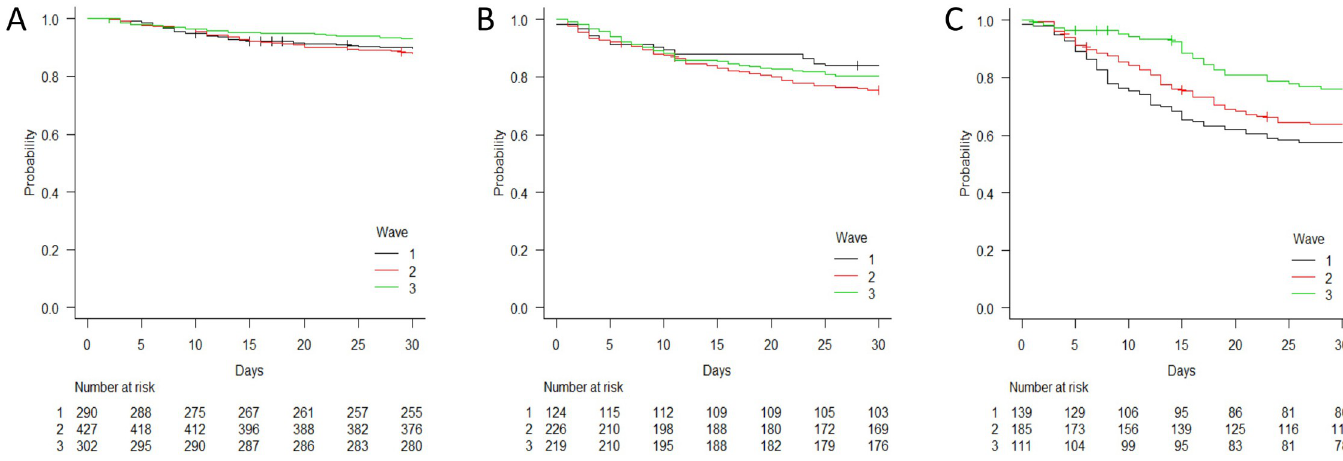
Fig 3. Time-dependent survival probability by period of hospital admission (wave 1 [February-July 2020], wave 2 [August 2020-January 2021], and wave 3 [February-April 2021]) stratified by disease severity upon hospital admission. A: mild/moderate disease; B: severe disease; C: critical disease.